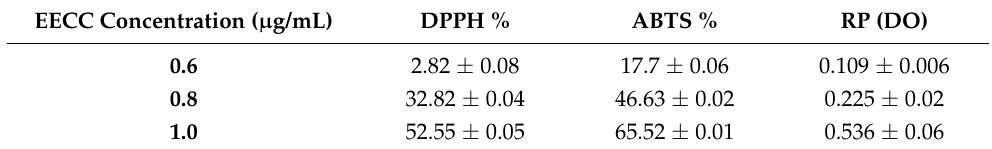
Table 2. Scavenging activity of ethanol extract C. calcitrapa . Data represent mean ± SD of triplicates.